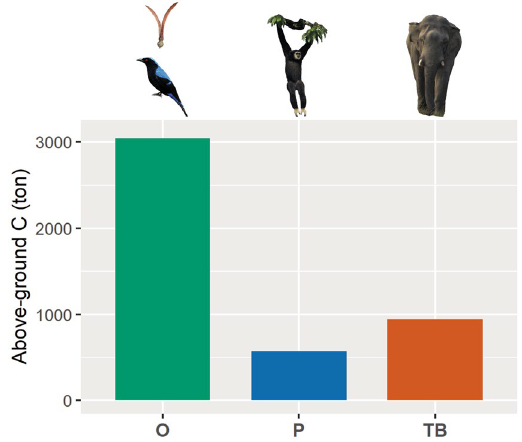
Figure 2. Share (%) of total above ground carbon (4,559.2 ton C/30 ha), considering only trees with dbh ≥ 5 cm categorized by dispersal modes (P is primates, TB is large-bodied terrestrial, mammals and birds, and O is other seed dispersal agents, mostly smaller birds and abiotic).